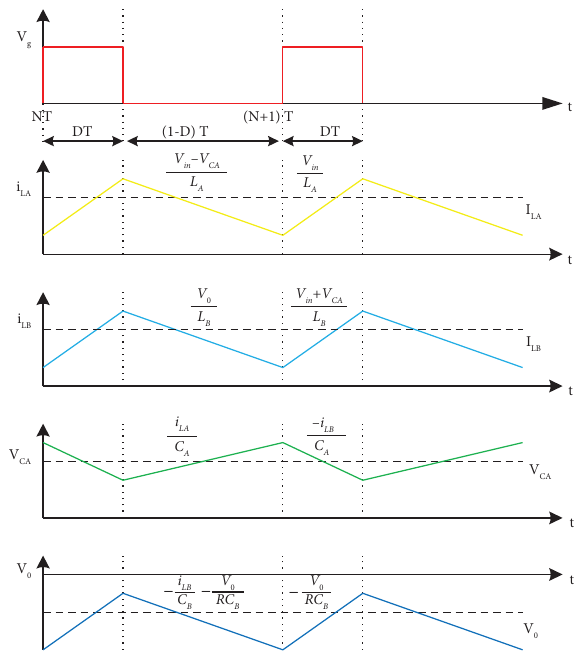
Figure 3: Te proposed converter’s time-domain waveforms under steady-state